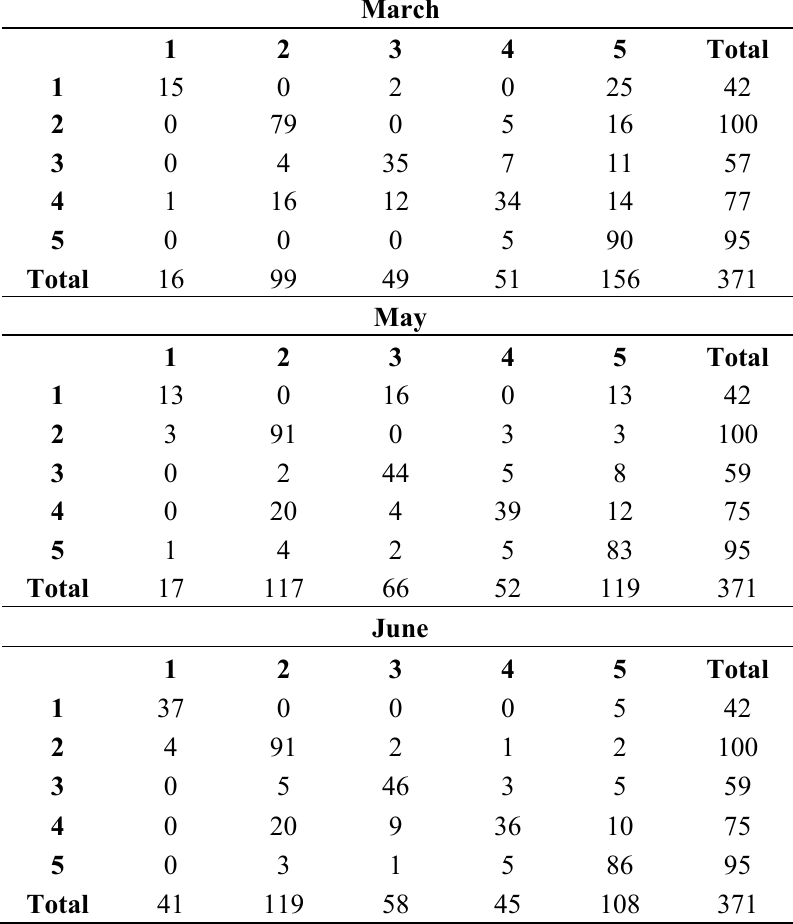
Table 10. Error matrices of mono-temporal LULC classifications of 2011, the values in all the tables refer to the numbers of pixels. 1: Water; 2: Woodland; 3: Bare surface; 4: Mixed vegetation; 5: Agricultural